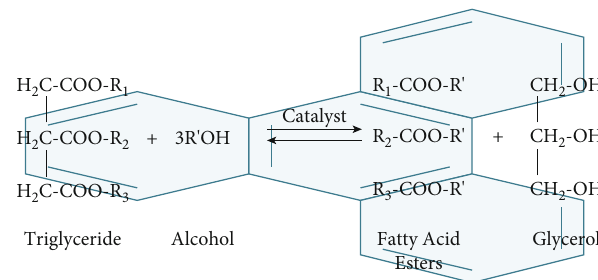
Figure 1: Chemical reaction of transesteri fi cation.